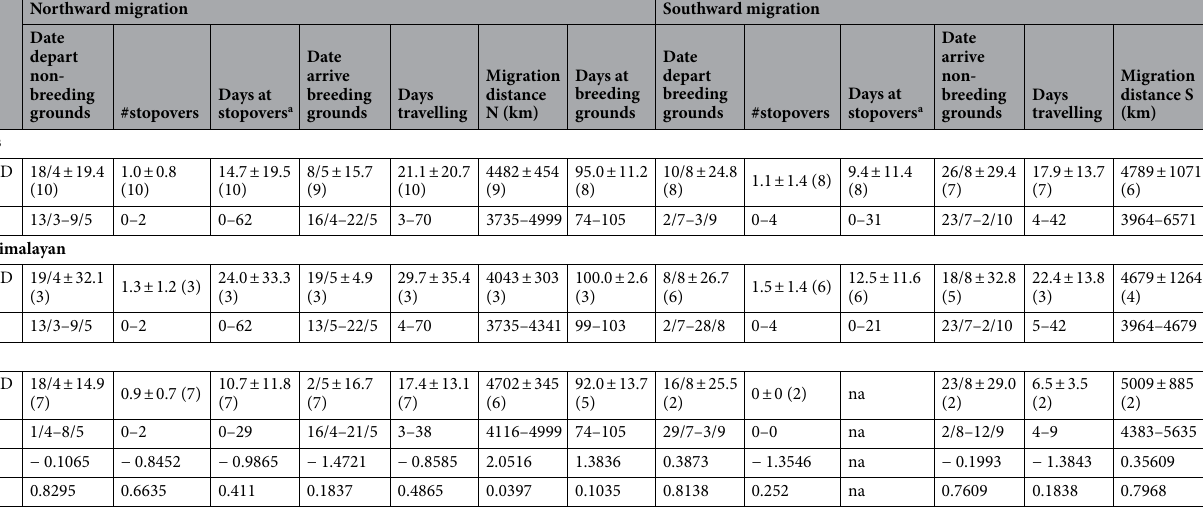
Table 2. Summary of migratory movements of adult Common Redshanks traveling between Singapore and their breeding grounds as determined by light-level geolocation and PTT satellite transmitters. Z-values and P-values are from permutation tests comparing trans-Himalayan and eastern migration routes. All dates are indicated by day/month/year in SGT(UTC + 8). a See methods. For the list of stopover sites see Supplementary Table